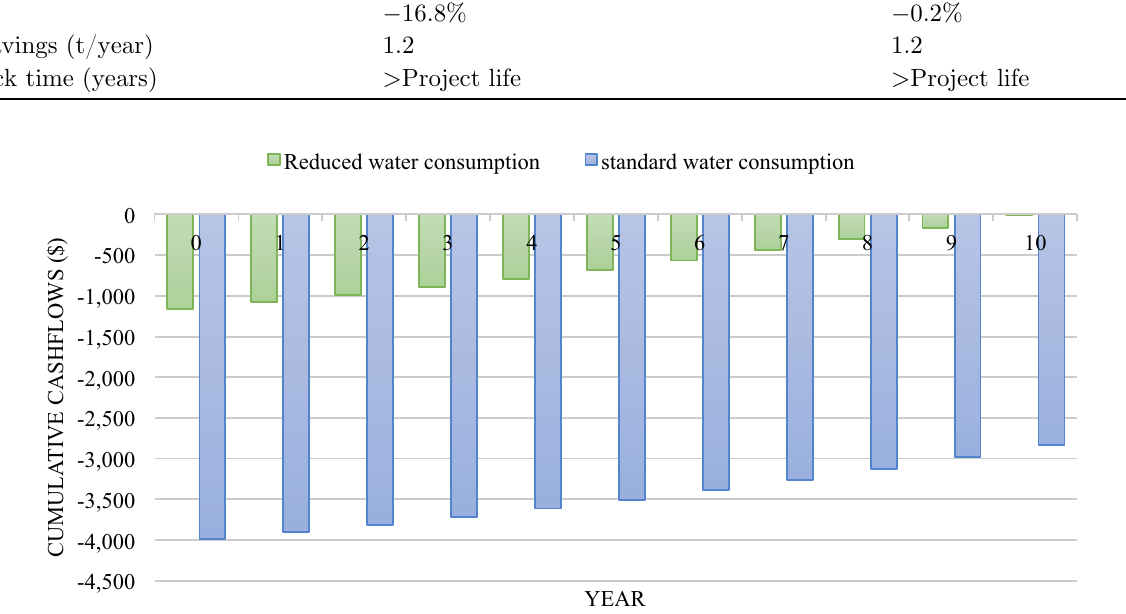
Fig. 2. Cumulative cash fl ow graph for the heating part (reduced and standard hot water